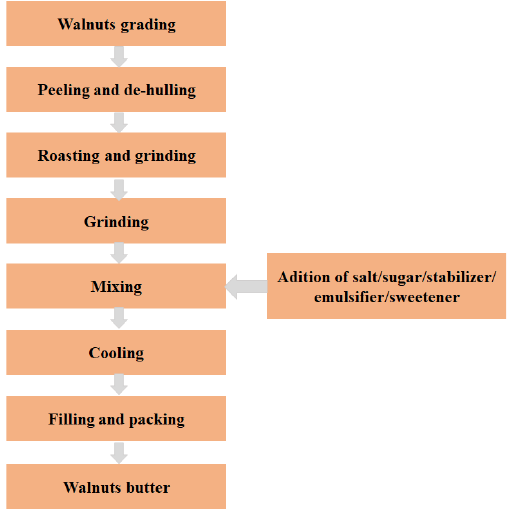
Figure 1. Flow diagram of walnuts butter production.